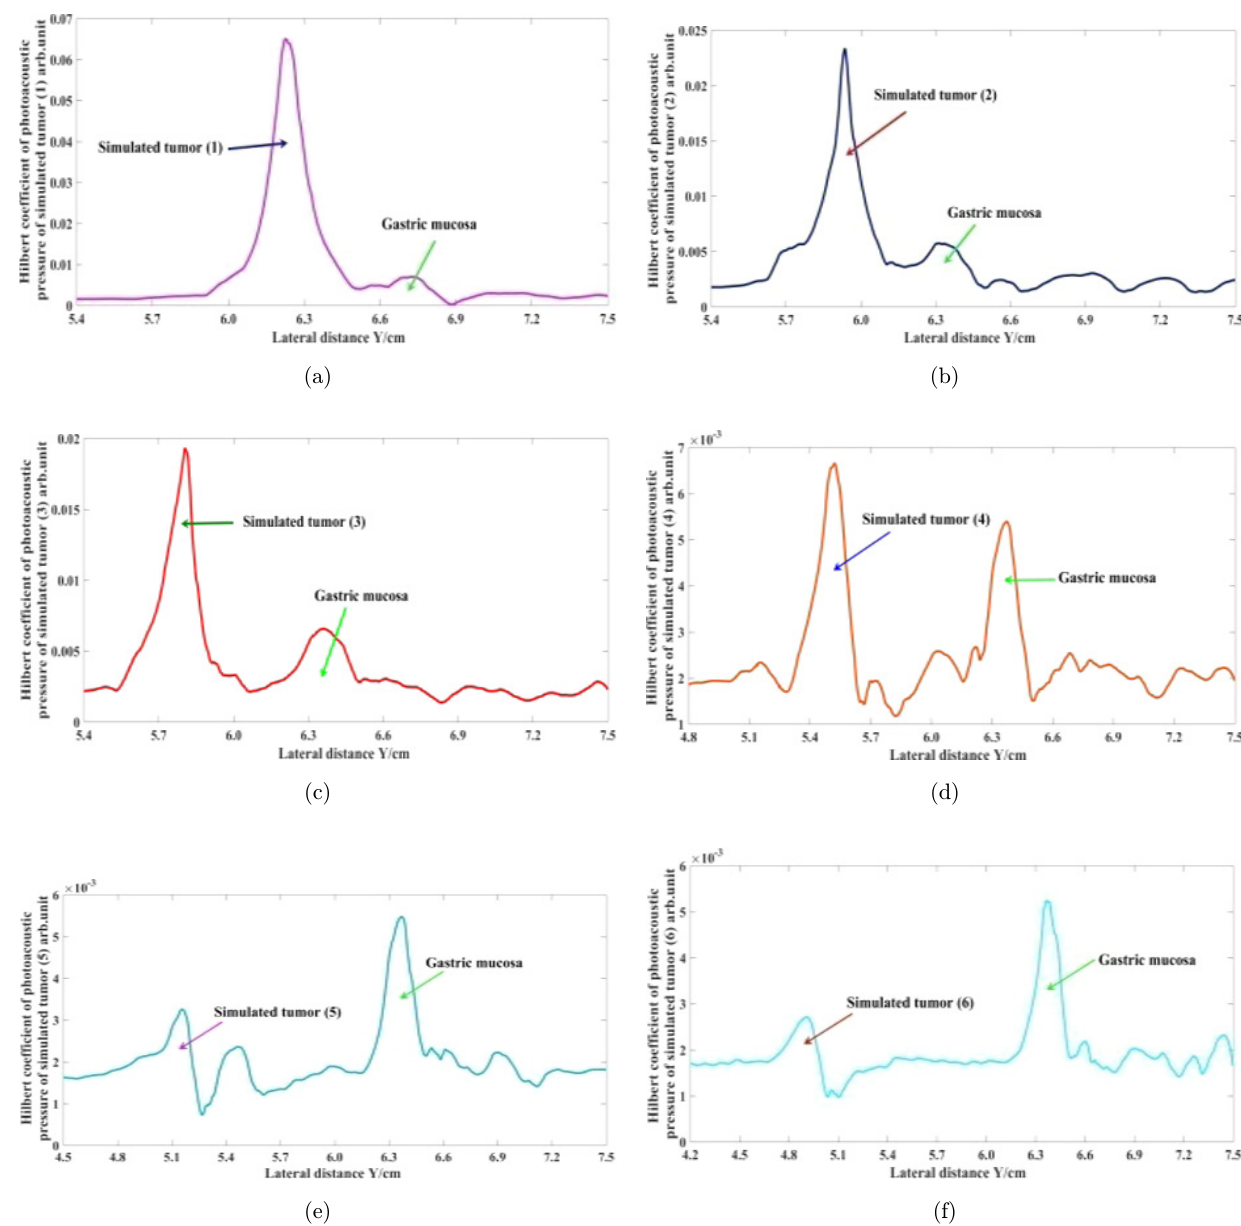
Fig. 7. PAI of simulated tumor (1) – (6) in longitudinal detection. (a) Hilbert transform results of photoacoustic signals of simulated tumor (1); (b) Hilbert transform results of photoacoustic signals of simulated tumor (2); (c) Hilbert transform results of photo- acoustic signals of simulated tumor (3); (d) Hilbert transform results of photoacoustic signals of simulated tumor (4); (e) Hilbert transform results of photoacoustic signals of simulated tumor (5); (f) Hilbert transform results of photoacoustic signals of simulated tumor (6); (g) Two-dimensional PAI of gastric tumor detection in animal phantom longitudinal detection; (h) Three-dimensional photoacoustic signal amplitude imaging of six simulated gastric tumors detection in animal phantom in longitudinal